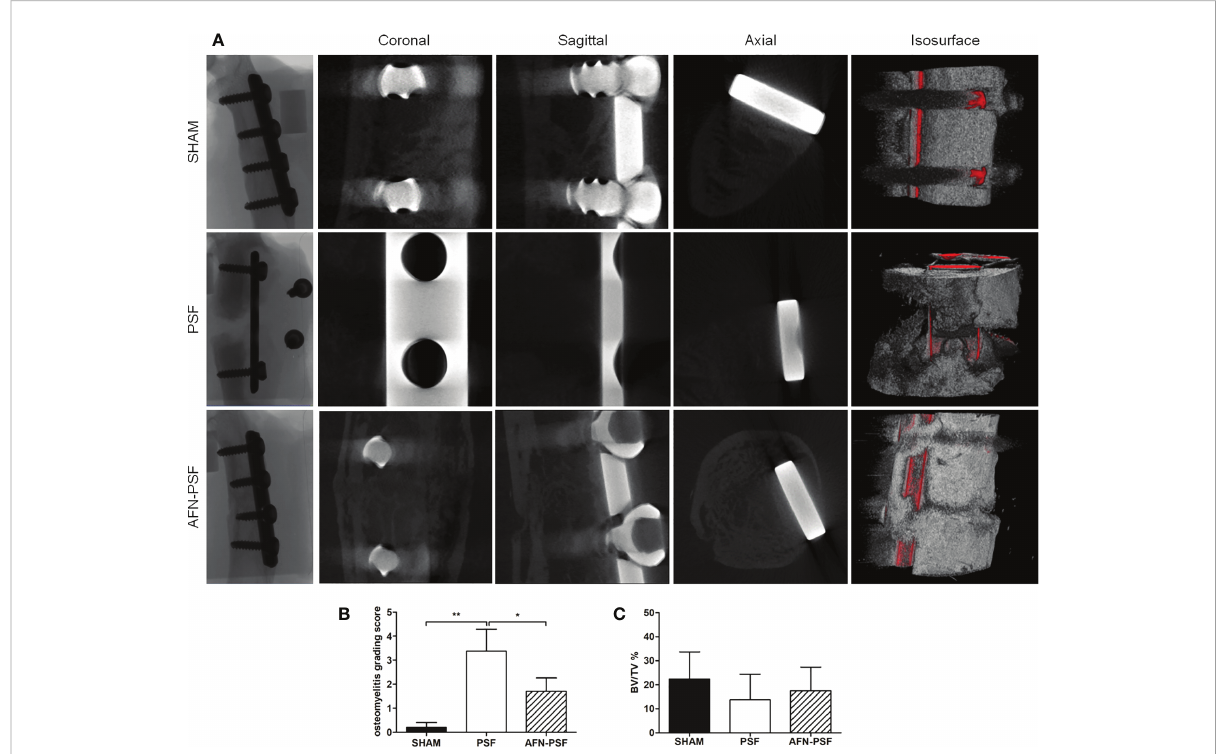
FIGURE 4 Qualitative micro-CT imaging, isosurface, and quantitative analyses. (A) The representative panel shows micro-CT images on the day of explantation at the sagittal, coronal, and axial planes. 3D isosurface reconstruction is also depicted. (B) Osteomyelitis grading score based on Odekerken ’ s scale is reported in the histogram in panel. (C) Quantitative BV/TV % is reported in panel. Comparisons among groups were analyzed with one-way ANOVA corrected with Bonferroni ’ s post hoc test. Statistical signi fi cance was p < 0.05 (*) and < 0.01 (**); n = 5 SHAM, n = 8 PSF, n = 10